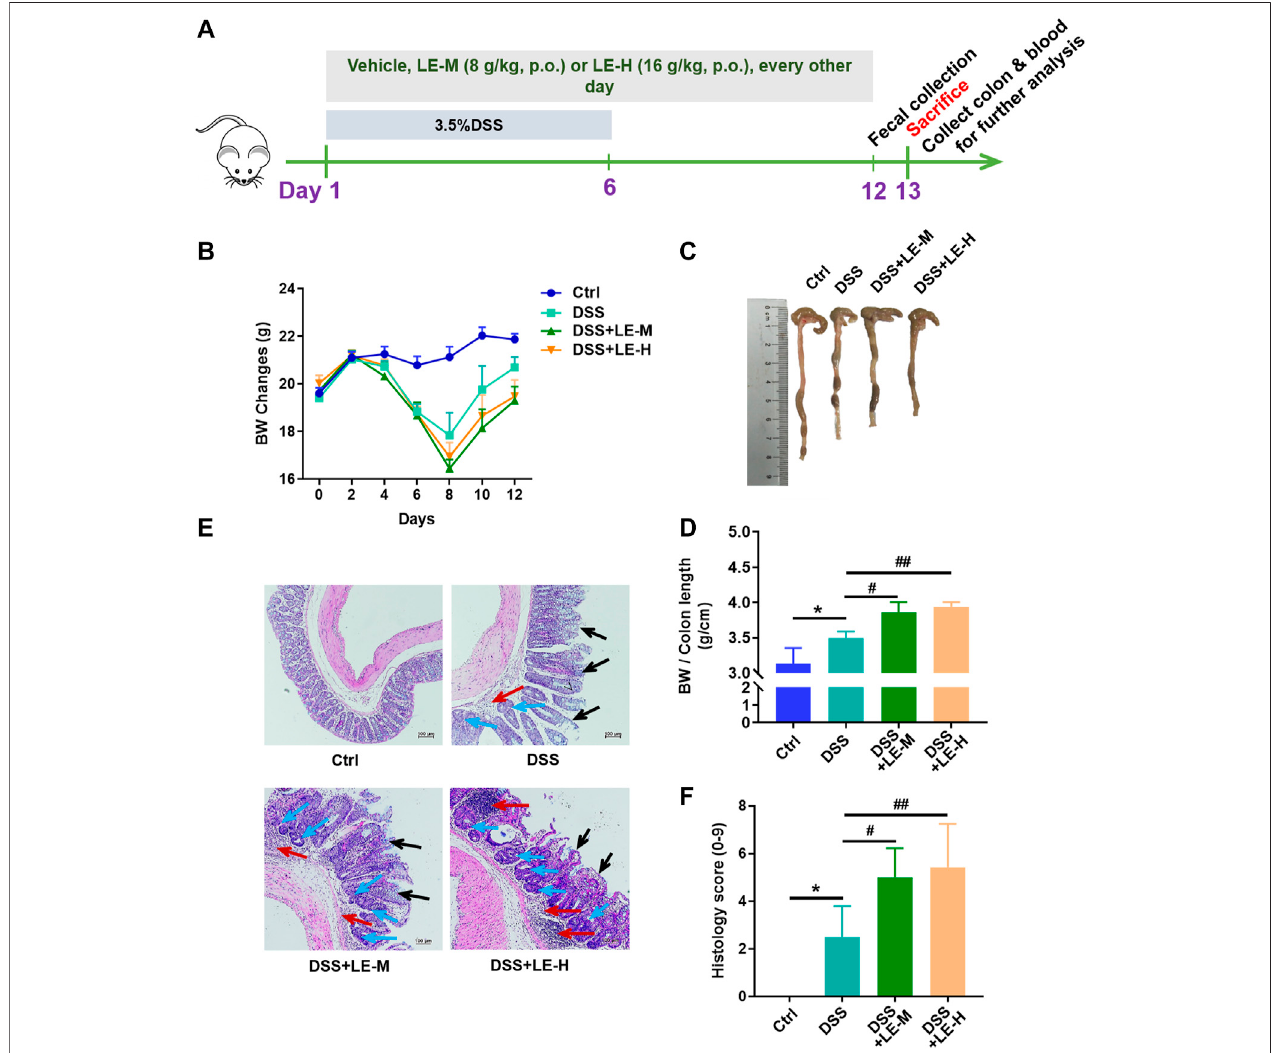
FIGURE 4 | Excessive intake of longan extract (LE) aggravates DSS-induced colitis. (A) Experimental design of mouse study (B) Body weight changes of mice ( n (cid:1) 10) (C) Colon length (D) Ratio of body weight to colon length ( n (cid:1) 7 – 10) (E) Histopathological changes of colon tissues after H and E staining. Red arrow shows in fl ammatory cell in fi ltration. Black arrow shows mucous membrane detachment. Blue arrow shows crypt distortion. (F) Histological score based on H and E-stained colonsections( n (cid:1) 6).Ctrl,controlmice;DSS,3.5%DSS-treatedmice;DSS+LE-M,3.5%DSS-treatedmicesupplementedwithmedium-doseLE(8 g/kg);DSS+ LE-H, 3.5% DSS-treated mice supplemented with high-dose LE (16 g/kg). Data are presented as mean ± SD. * p < 0.05, ** p < 0.01, *** p < 0.001, compared to Ctrl; # p < 0.05, ## p < 0.01, compared to DSS group.